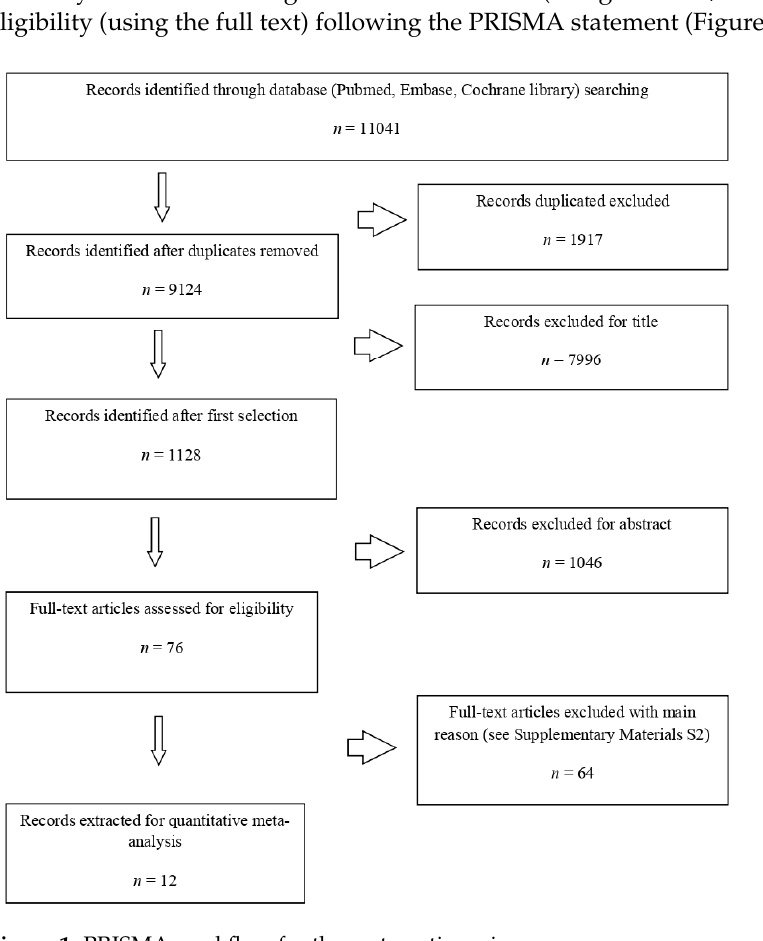
Figure 1. PRISMA workflow for the systematic